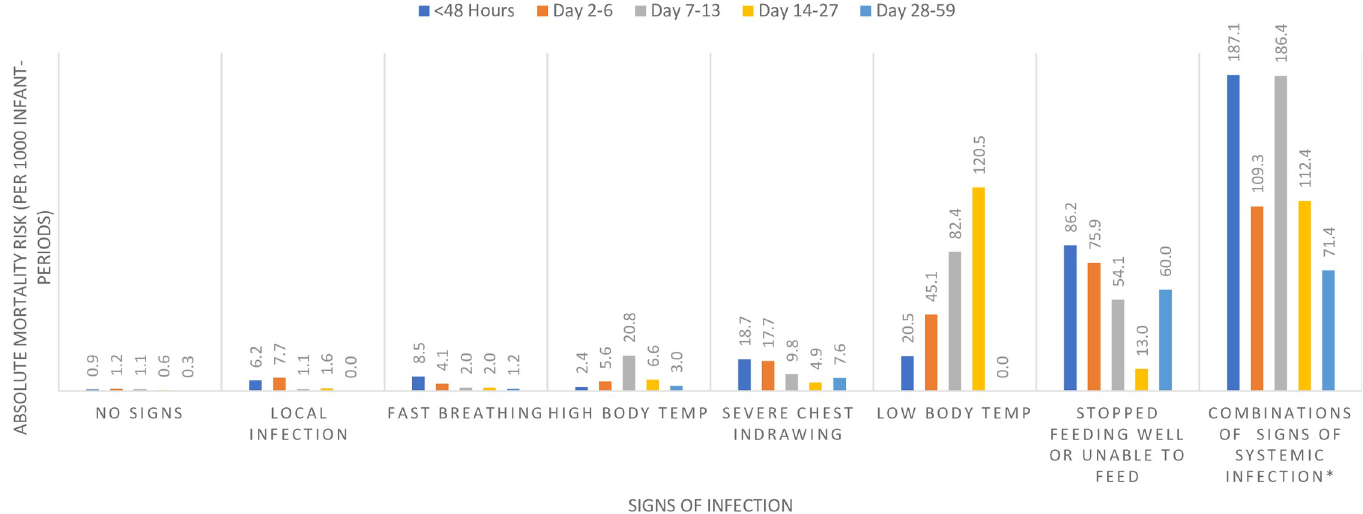
Fig 3. Distribution of risk of mortality associated with signs of infection† (per 1000 infant-periods) in the first two months of life. † ‘Reported convulsions’ was excluded from the figure as no deaths occurred in young infants with only convulsions. ‘Movement only when stimulated or no movement at all’ was excluded due to low prevalence ( < 20 cases) per visit. � These children had multiple signs of systemic infection.